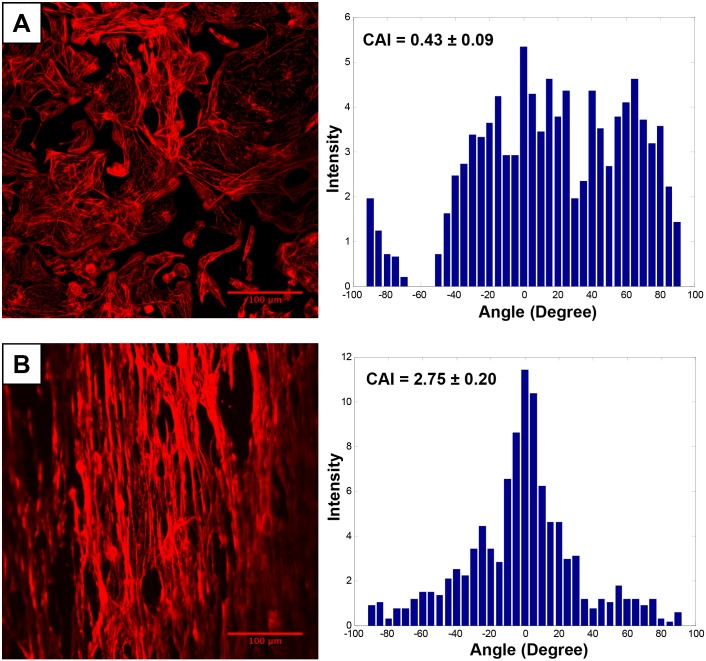
The alignment of hiPSC-CMs.Cells seeded on A) Flat surface plate and B) Aligned nanofiber characterized by cell anisotropic index (CAI). The hiPSC-CMs were stained with phalloidin dye (Red) to determine the alignment of seeded cells. CAI was significantly increased in the aligned nanofiber group.